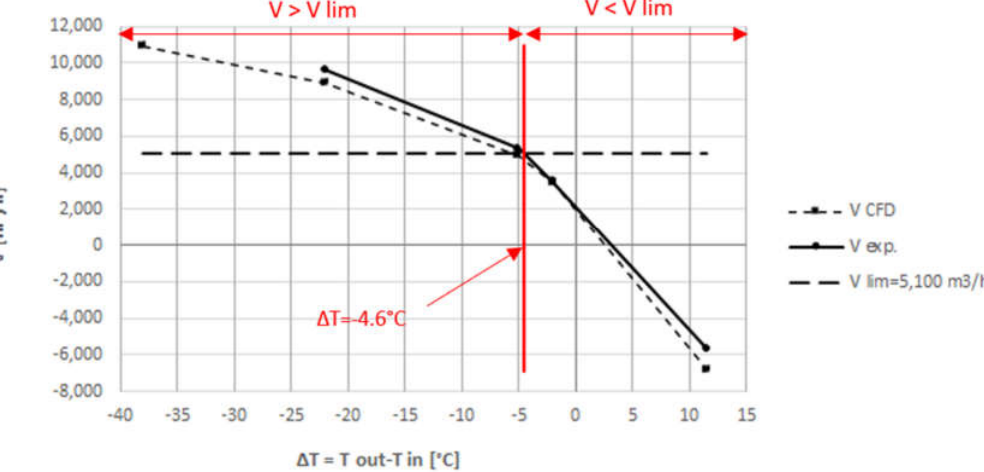
Figure 13. Air volume flow through the smoke damper for several temperature variances.